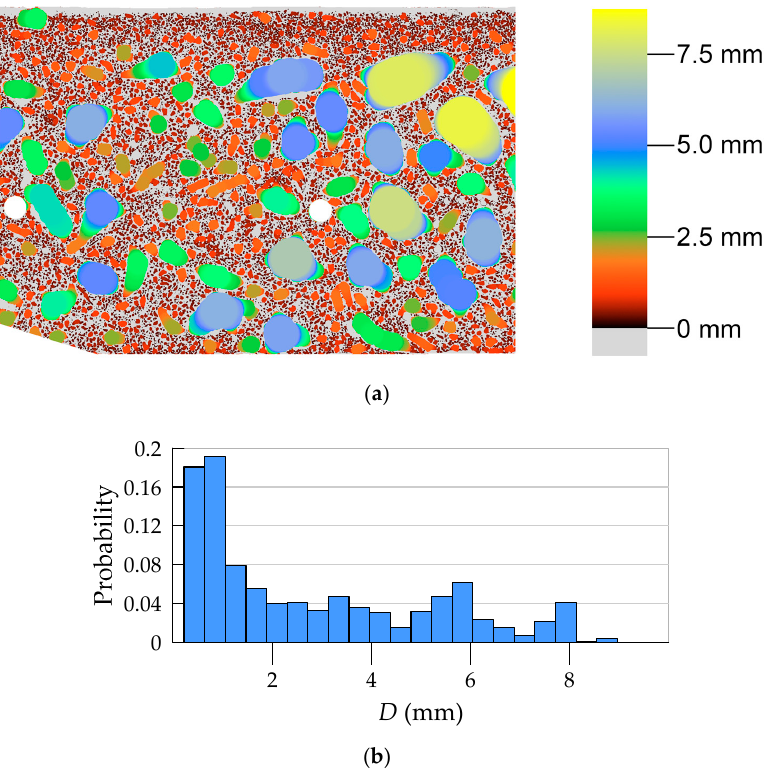
Figure 15. Local thickness of aggregate: ( a ) contour map (limited to ROI); ( b ) histogram. Materials 2020 , 13 , x FOR PEER REVIEW